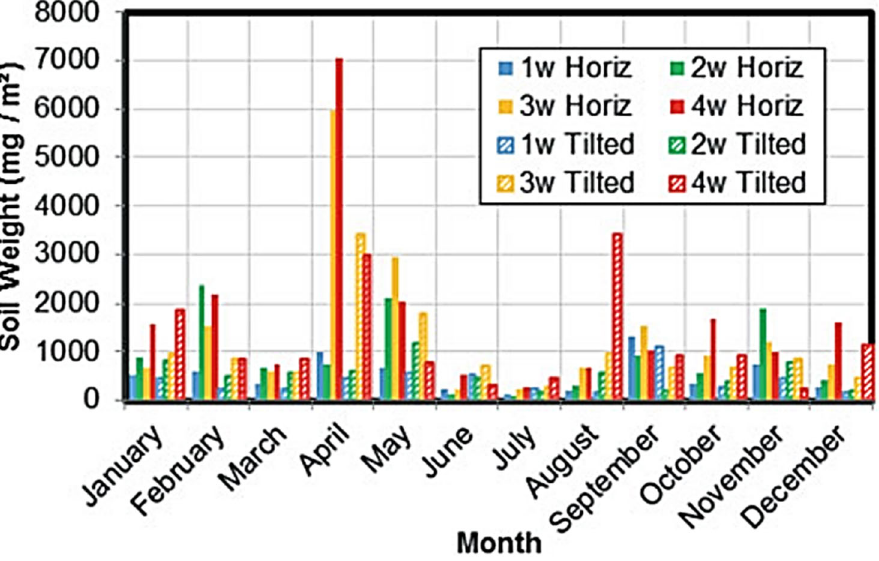
Figure 11. Monthly dust accumulation weight on horizontal and tilted glass (tilt angle of 15°) [60].